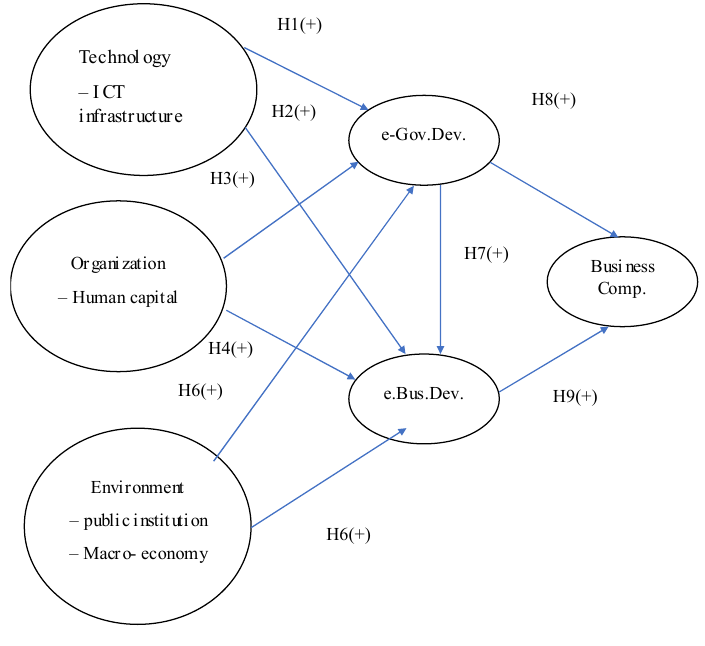
Fig. 1. Study Model (Source: Shirish,